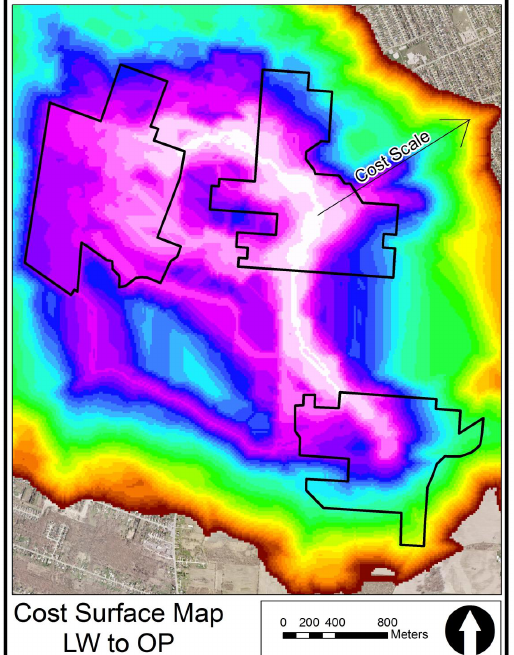
Figure 3. Cost surface map of the landscape between Ojibway Prairie Provincial Nature Reserve (OP; top left), Spring Garden Area of Natural and Scientific Interest (top right) and LaSalle Woodlot Environmentally Significant Area (LW; bottom right). The arrow designates the increasing cost scale. A series of 11 nested ‘permeability swath’ polygons were produced from the CCM which depict successive swaths of permeability (0.1%, 1%, 2%...10%). For example, the 0.1% swath depicted the most permeable 0.1% of the landscape area between population blocks. Each swath is defined by the largest cost allowed within that particular polygon. As each successive swath was activated, the most permeable pathway (0.1%) is widened and new pathways appeared. High-ranking PCPs were selected based upon the most permeable 0.1% and 1.0% of the landscape between each pair of population blocks. Lower ranking PCPs were identified by activating successive permeability